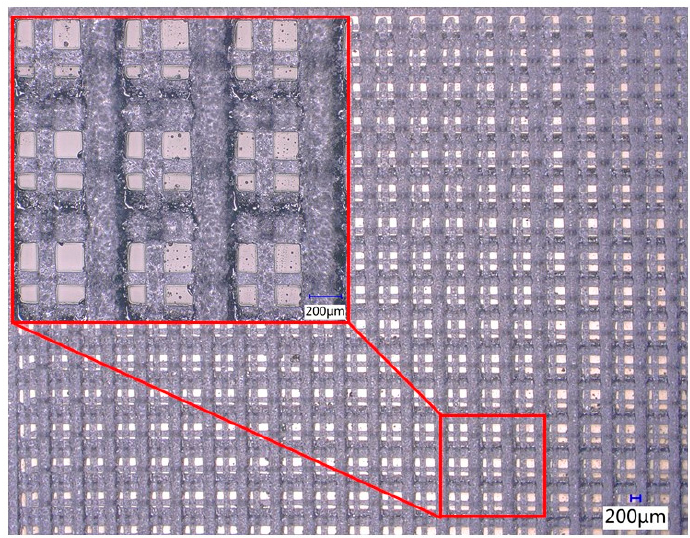
Figure 16. Morphology of cruciform secondary microstructures on the surface of PMMA specimen.